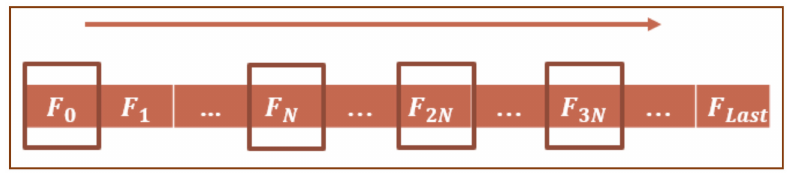
Figure 3. Keyframes selection using sliding window.